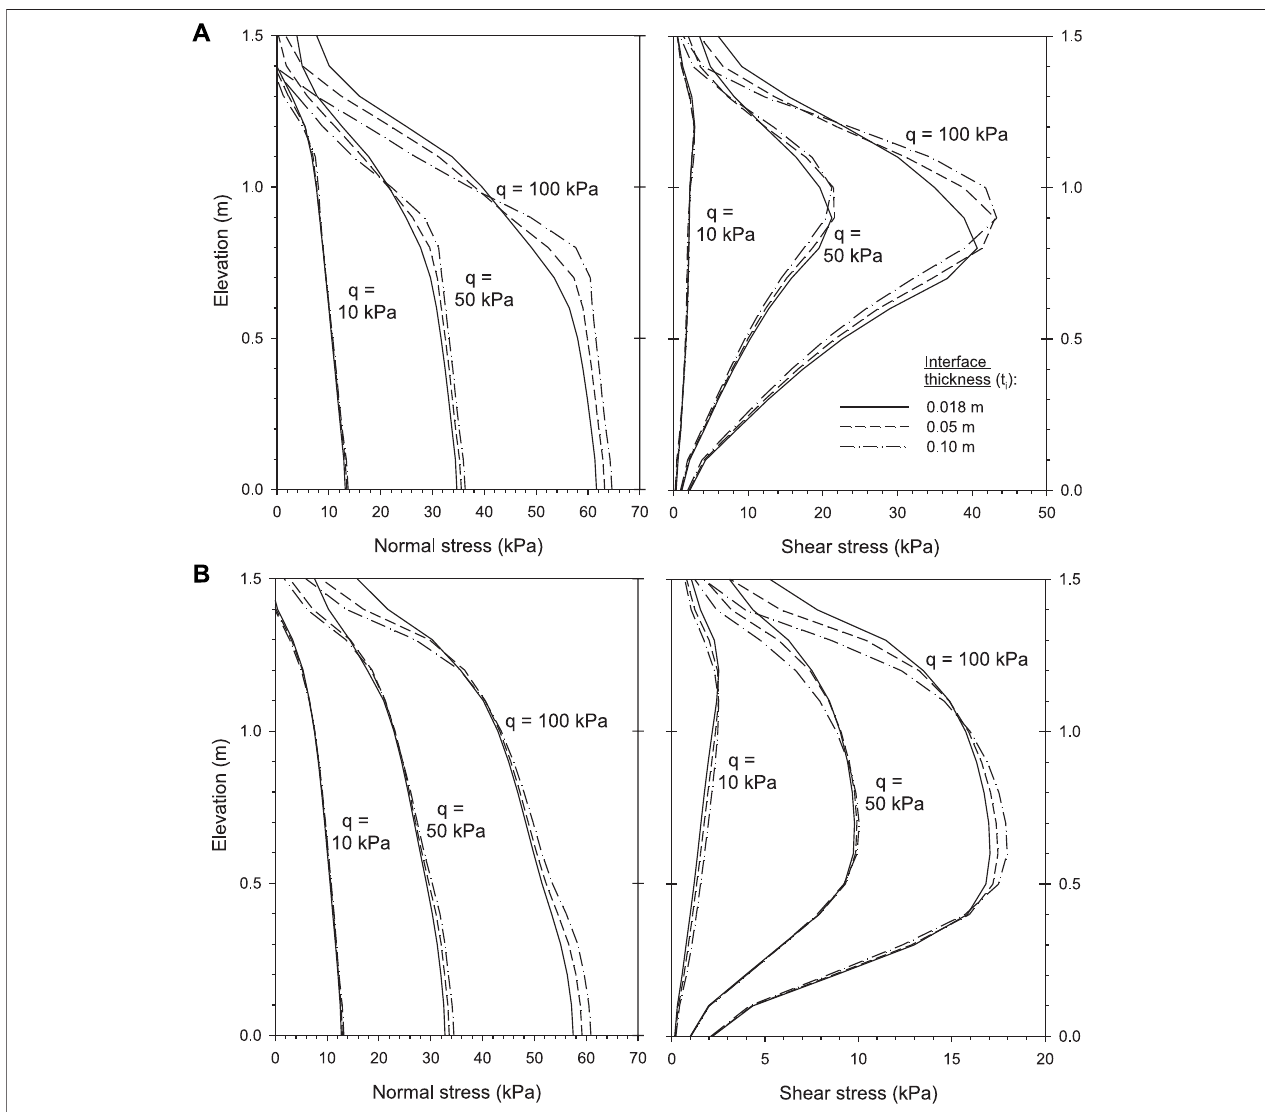
FIGURE14| Loadtransferfromback fi llsoiltofacingpanelusingprogramCODE_BRIGHT:normalandshearstressesforinterfacethicknessesofti = 0.018,0.05, and 0.10 m. Cross-section at x = 0.509 m. Cases with (A) Ri = 0.8 and (B) Ri = 0.3.